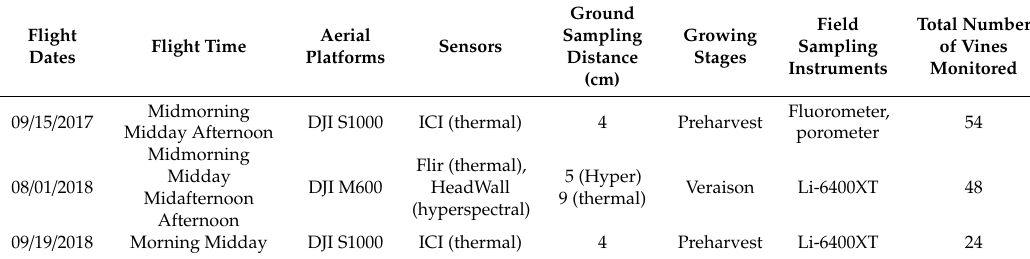
Table 1. Summary of field campaign dates, platforms, sensors, sampling instruments, and the number of grapevines monitored for stomatal conductance (G s ) and steady-state fluorescence (F s